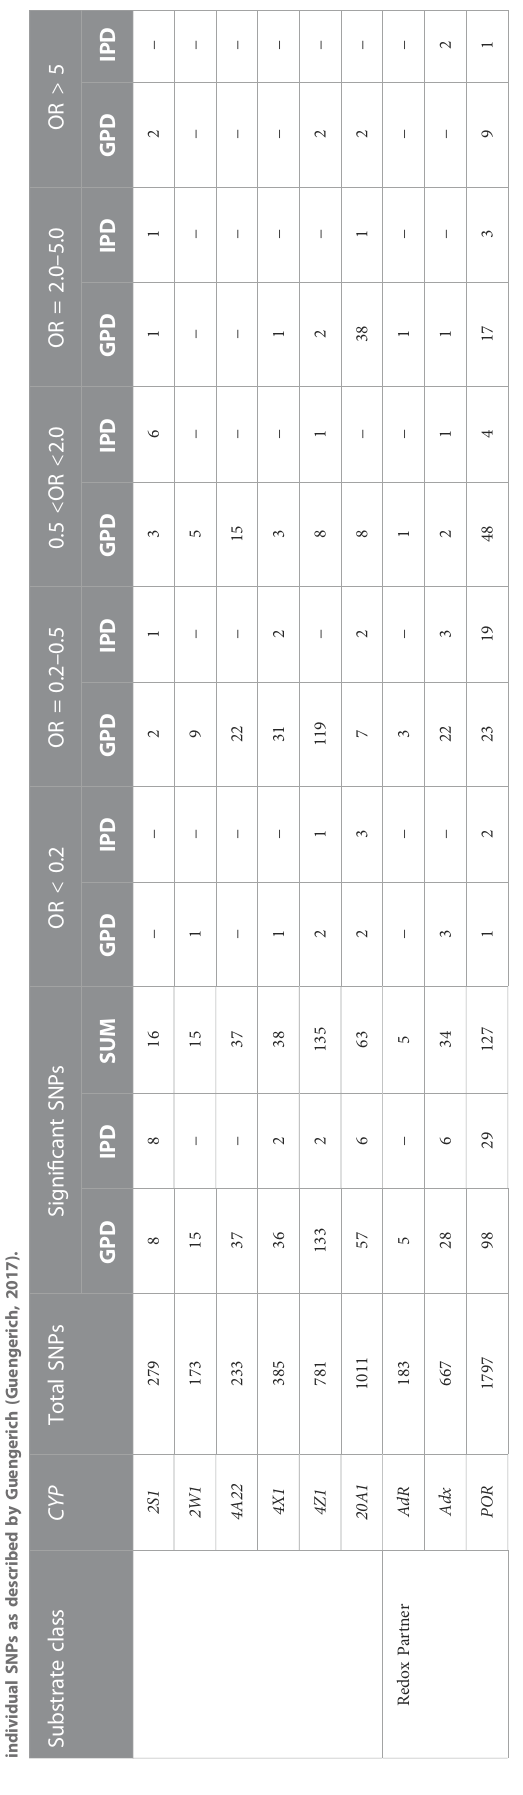
(Table 2; Table 3) demonstrating that GPD patients have an up to 9.5- fold over-representation (higher odds) of one of these gene variations compared with HC. This means that only patients which have a predisposition for PD due to mutations in one of the genes like LRRK2, SNCA etc. are prone to develop PD when the CYP2D6 gene is mutated, whereas none of the SNPs alone (OR values in IPD patients of 0.228 and 0.229 were found) seems to be suf fi cient to cause symptoms of PD. SNP rs76015180 (OR = 9.49) was found in intron 5, while the other two SNPs with OR values > 5 are in the downstream region. The functional effect for the corresponding CYP2D6 gene products was classi fi ed as “ modi fi er ” by the used programs and no other information was found in the literature with regard to these